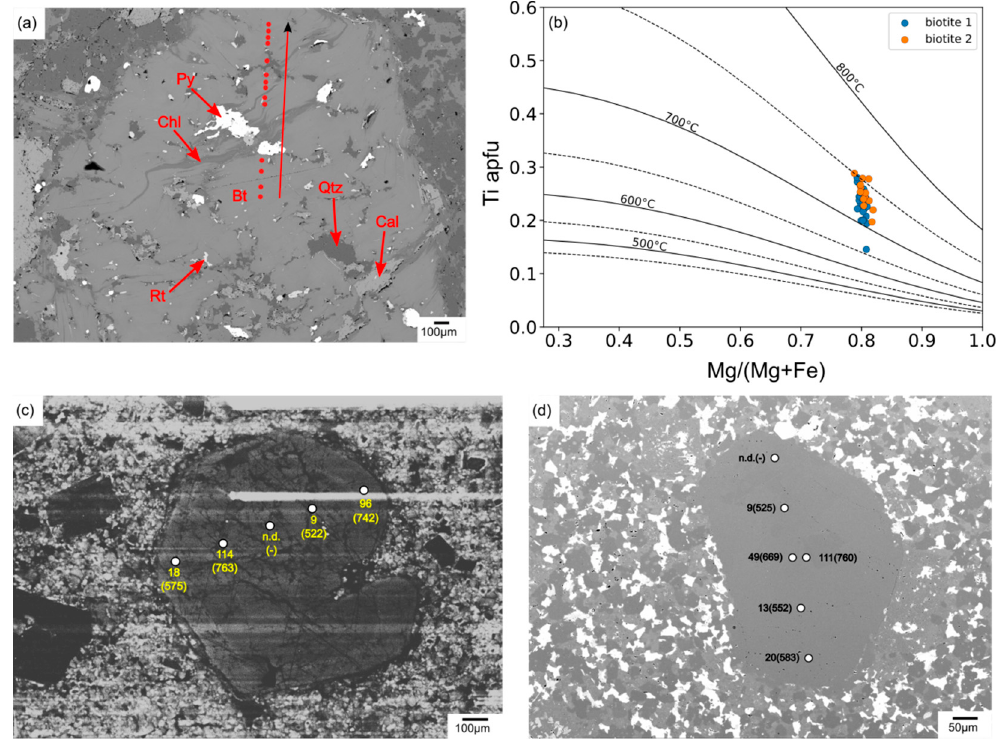
Figure 6. ( a , b ) Temperatures estimated using the Ti-in-biotite geothermometer of [26] (apfu = atom per formula unit). The host rock records temperatures of 700–750 °C. ( c , d ) Temperatures estimated using the Ti-in-quartz geothermometer. The quartz phenocrysts record temperatures of 400–750 °C.